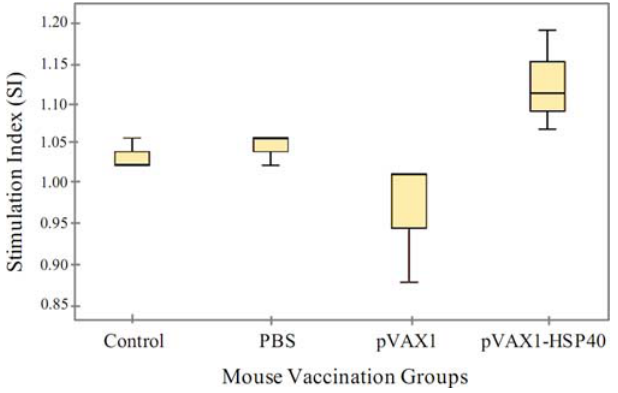
Figure 7. Lymphocyte proliferation assay. Splenocytes were obtained from immunized mice and the control groups prior to the challenge and cultivated in 96-well plates. Lymphocyte stim- ulation index was determined using the MTS assay. No significant difference was detected between pVAX1-HSP40-immunized group and control mice ( p >